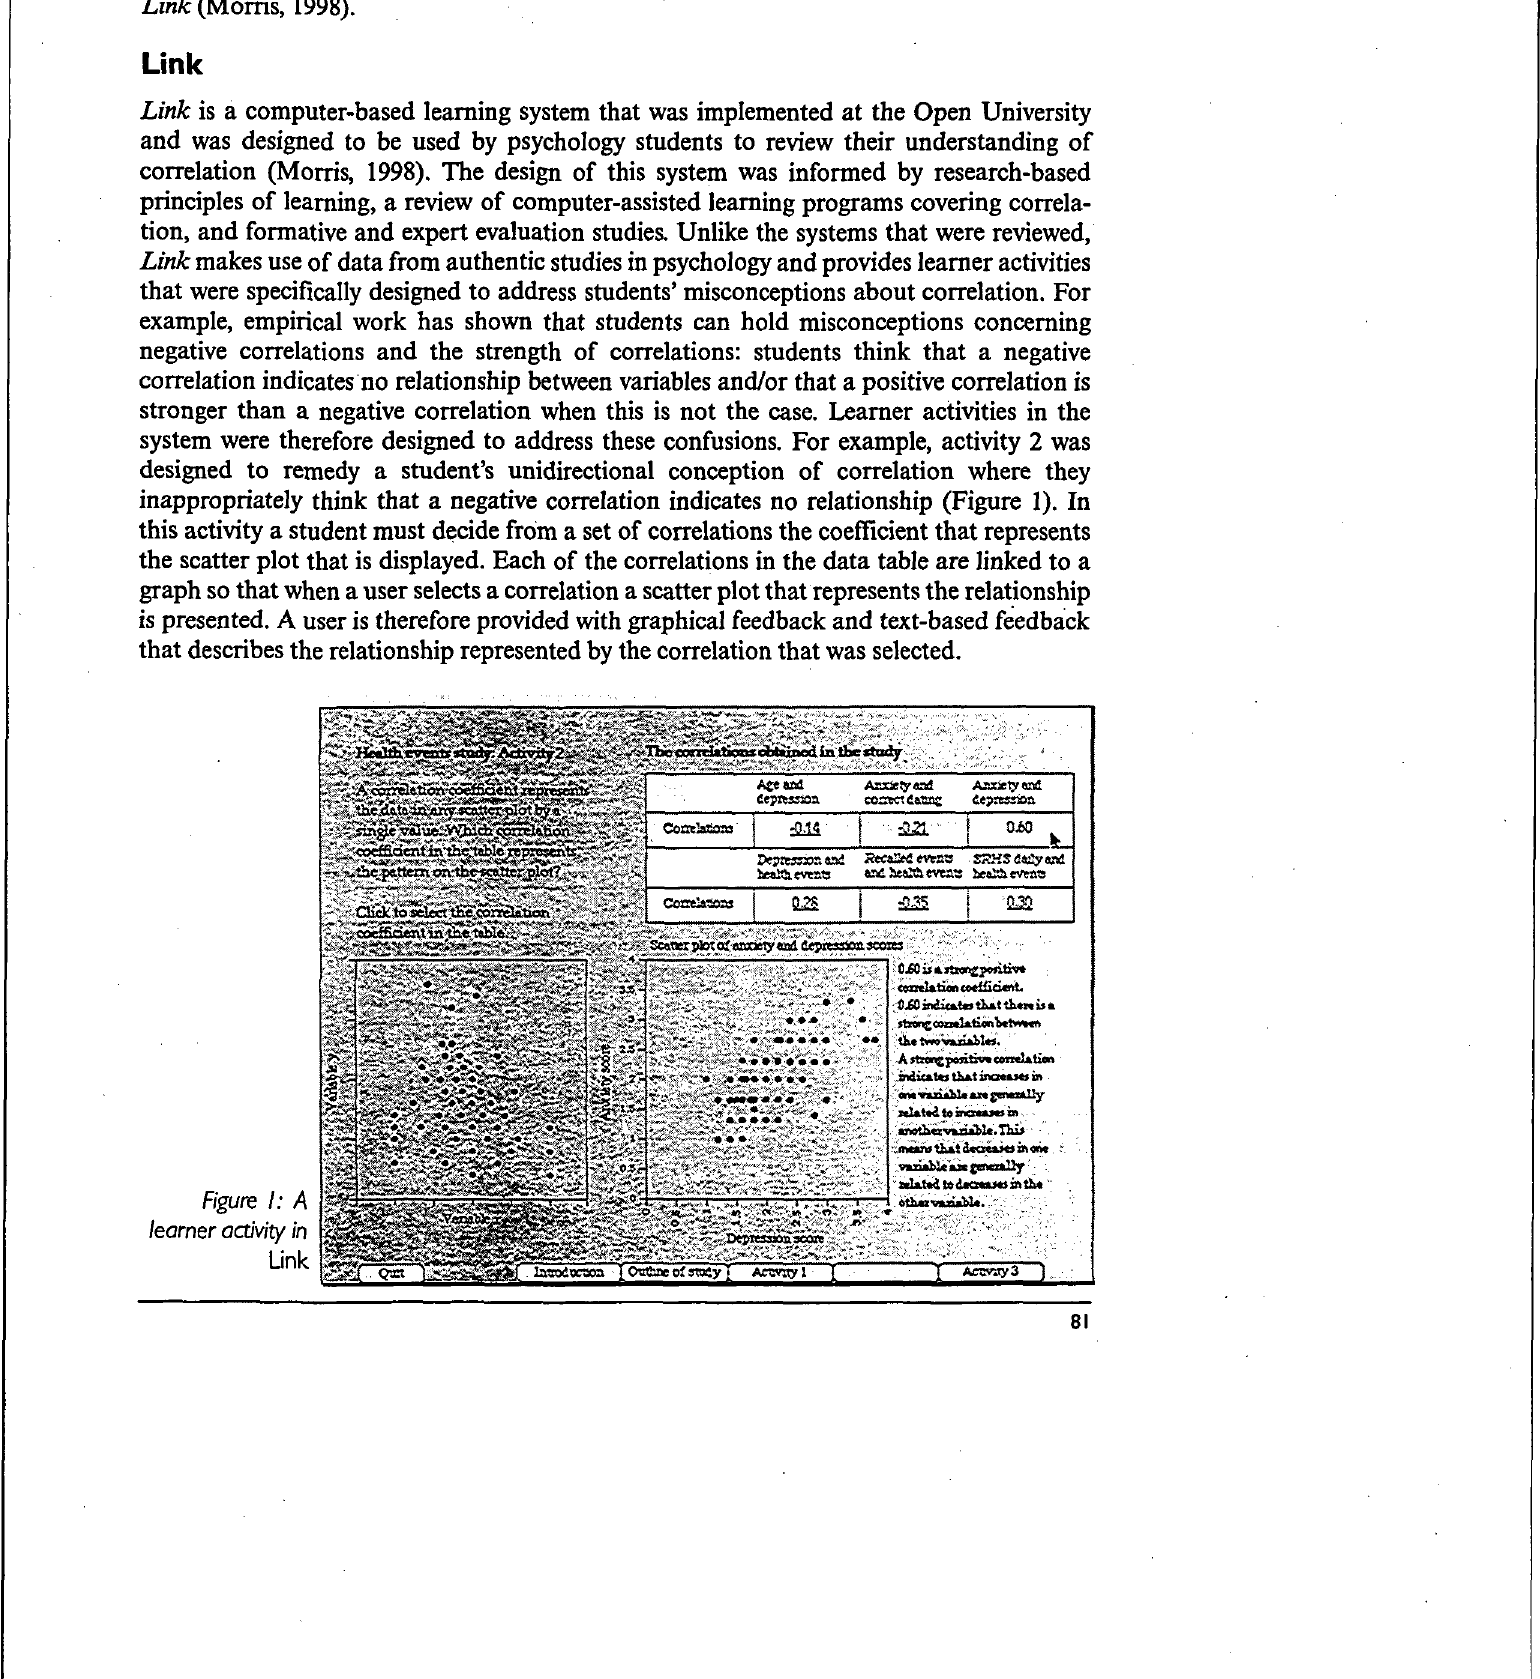
Figure I: A learner activity